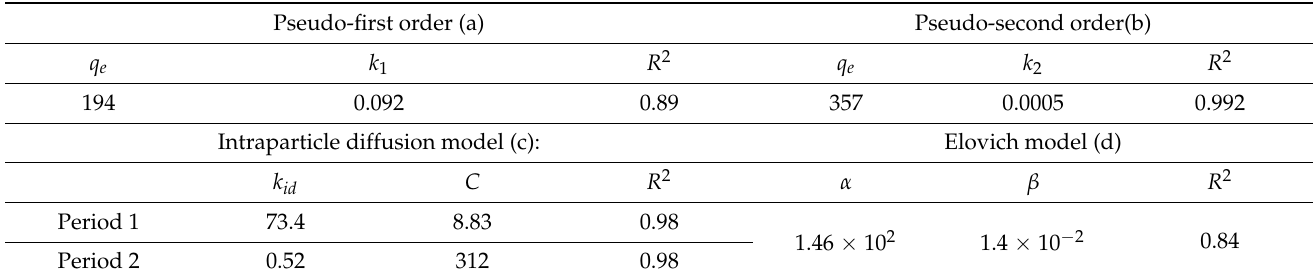
Table 4. Parameters of the sorption kinetics of zinc ions.